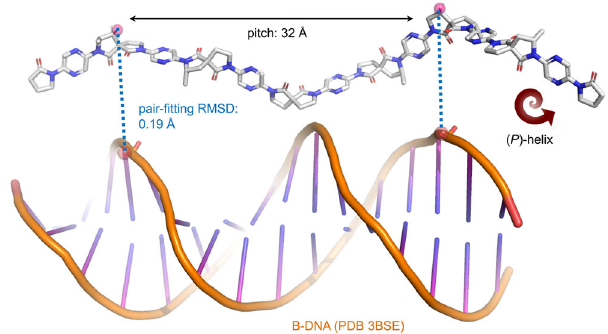
Fig. 5 Computed lowest energy conformation of pseudo -hexamer 13. Side- chains are truncated to CH 3 . Semi-empirical: PM7 (MOPAC2016) 75 – 77 . Pair- fi tting of spirocycle substituents within monomers n and n + 4 with phosphate oxygen atoms on surface of B-DNA (PDB 3BSE). For full details see Supplementary Discussion section 2.3.